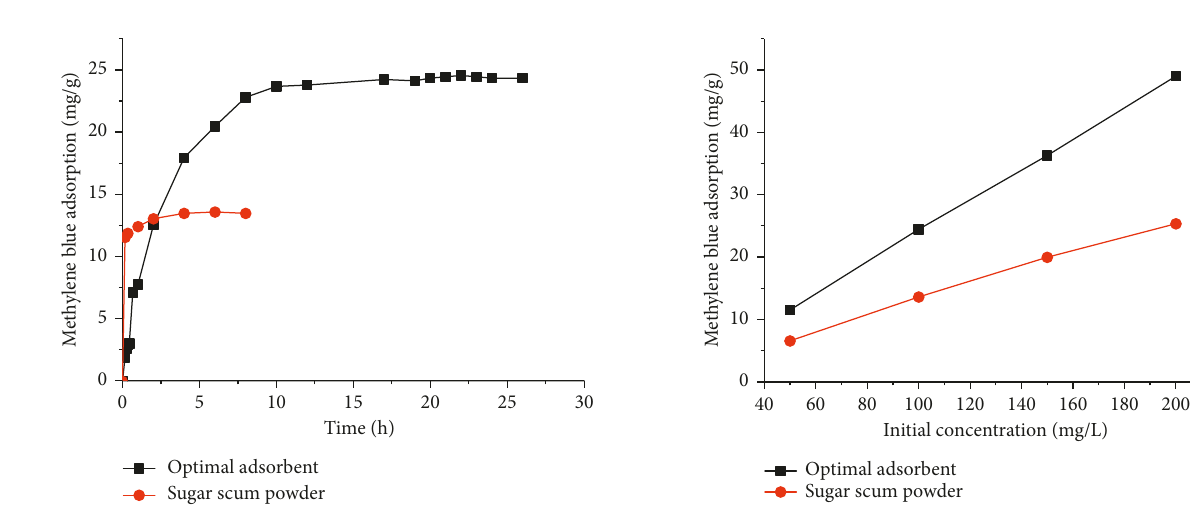
Figure 5: Effect of contact time on the adsorption of methylene blue on optimal adsorbent and sugar scum powder (adsorbent